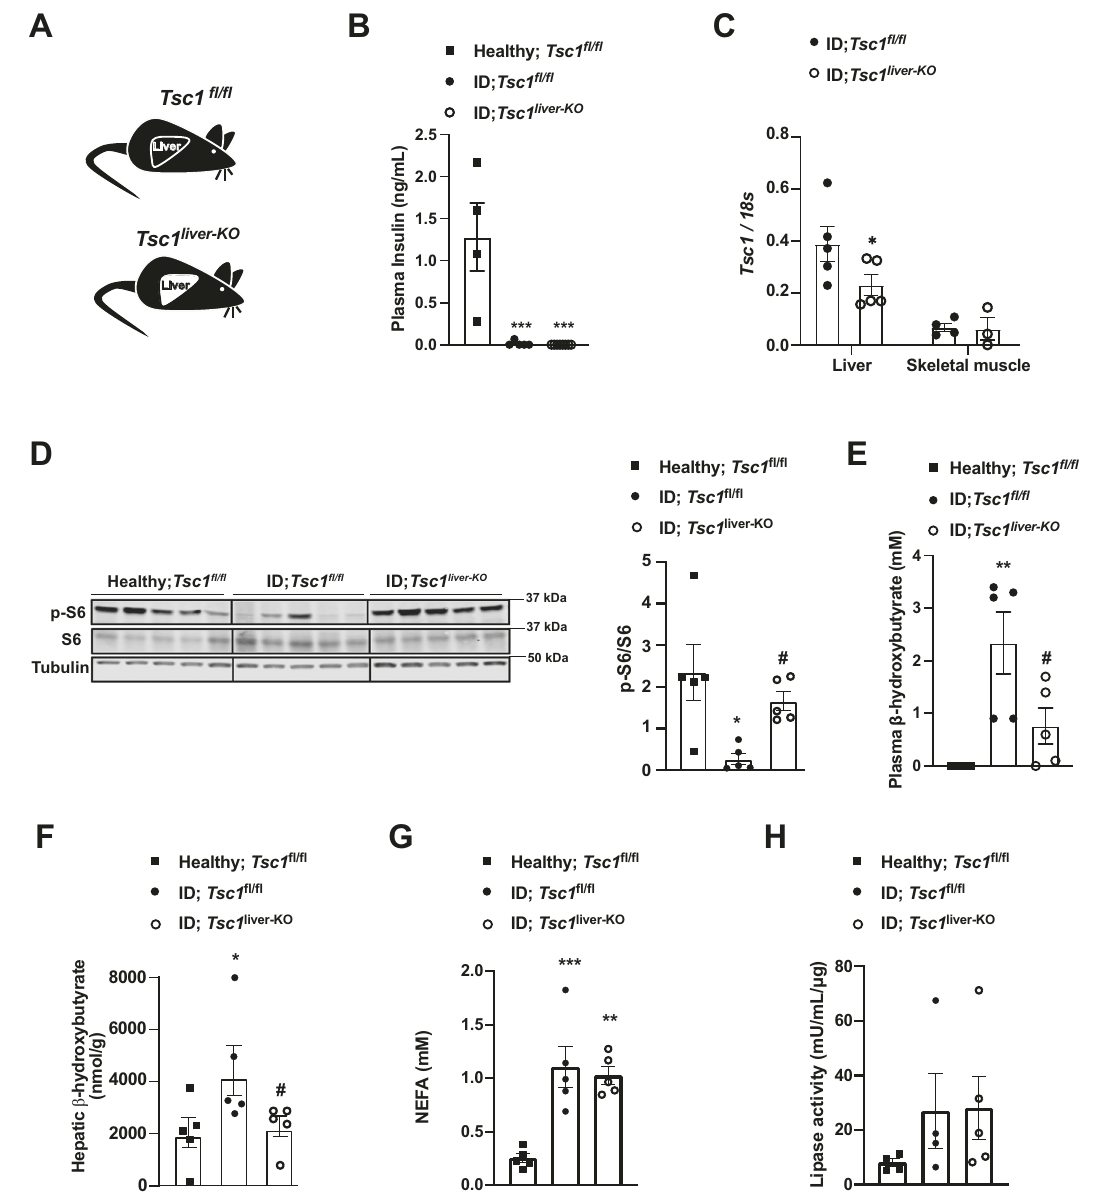
Fig. 3 Liver speci fi c up-regulation of mTORC1 signaling prevents hyperketonemia in ID. A Experimental groups. Homozygous Tuberous sclerosis complex 1 fl oxed ( Tsc1 fl / fl ) mice were administered 1 × 10^9 PFU Adenovirus serotype 5 expressing Cre and GFP (Cre recombinantion results in a Tsc1 null allele in the liver of Tsc1 fl / fl mice): Tsc1 liver-KO . Control mice were treated with 1 × 10^9 PFU Adenovirus serotype 5 expressing only GFP: Tsc1 fl / fl . B Plasma insulin levels of insulin de fi cient mice and healthy controls ( p = 0.0003 and p = 0.0001). C mRNA content of Tcs1 in the liver ( p = 0.0584) and skeletal muscle (gastrocnemius) of the indicated groups. D Image of immunoblot for the indicated proteins and phosphorylation states and relative densitometry quanti fi cation of pS6/S6 ( p = 0.011, p = 0.05). E Plasmatic β -hydroxybutyrate levels of indicated groups ( p = 0.008, p = 0.048). G Plasma NEFAs level ( p = 0.008, p = 0.002). H Lipase activity from perigonadal fat. ( n /group = 5, 5 and 5) Error bars represent SEM. Statistical analyses were done using one-